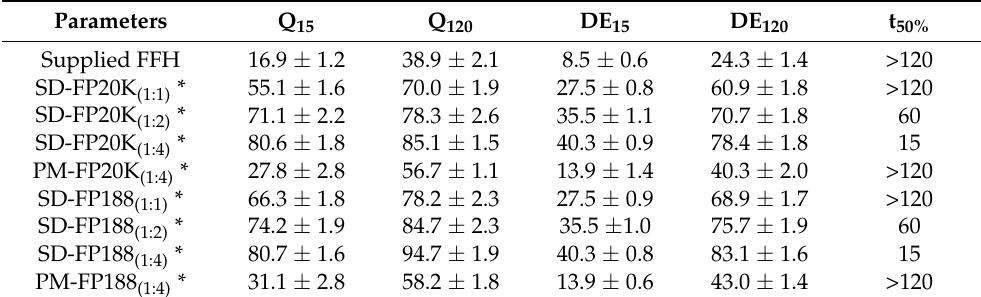
Table 2. Summary of dissolution parameters for supplied fexofenadine hydrochloride, solid dispersions and physical mixtures prepared using PEG 20,000 and poloxamer 188. Q 15 and Q 120 —percent drug released at 15 and 60 min; DE 15 and DE 120 : dissolution efficiency at 15 and 120 min; t 50% —time (min) taken to release 50% of the drug, FFH, fexofenadine hydrochloride; SD-FP20K—solid dispersion of FFH with PEG 20,000, PM- FP20K—physical mixture of FFH with PEG 20,000, SD-FP188—solid dispersion of FFH with poloxamer 188, PM-FP188—physical mixture of FFH with poloxamer 188, respectively. * Numbers represent the weight/weight ratios of